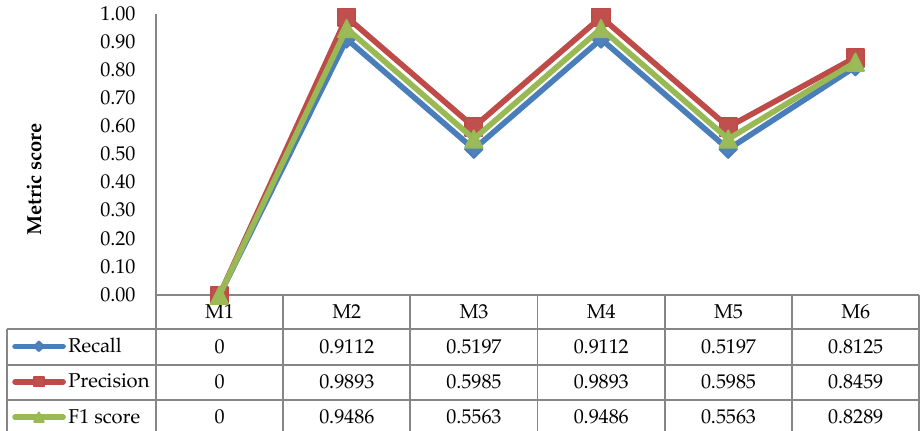
Figure 16. Average recall, precision, and F1 scores of Ara2012.